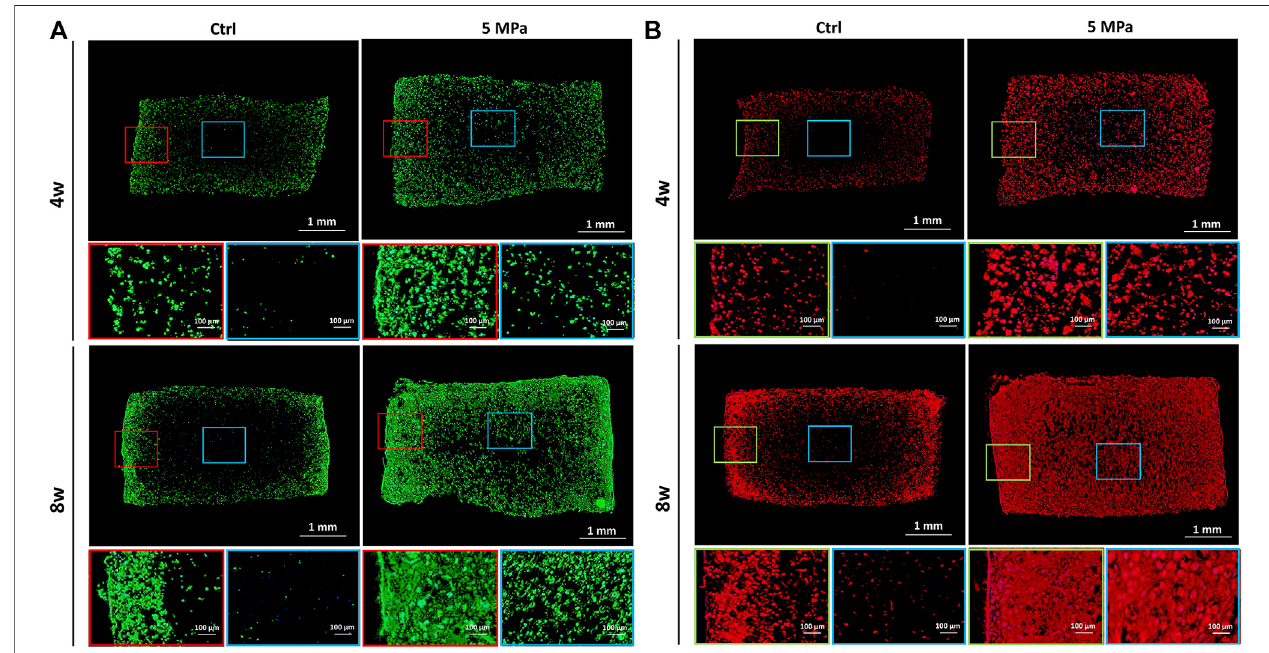
FIGURE 4 | Immuno fl uorescent staining evaluation of in vitro regenerated cartilage based on HPC hydrogels. (A) Immuno fl uorescent staining of phalloidine of CHPCcultured invitro . (B) Immuno fl uorescentstainingoftypeIIcollagenofCHPCcultured invitro .Redandgreenframesindicatetheperipheralregionsandblueframes indicate the central